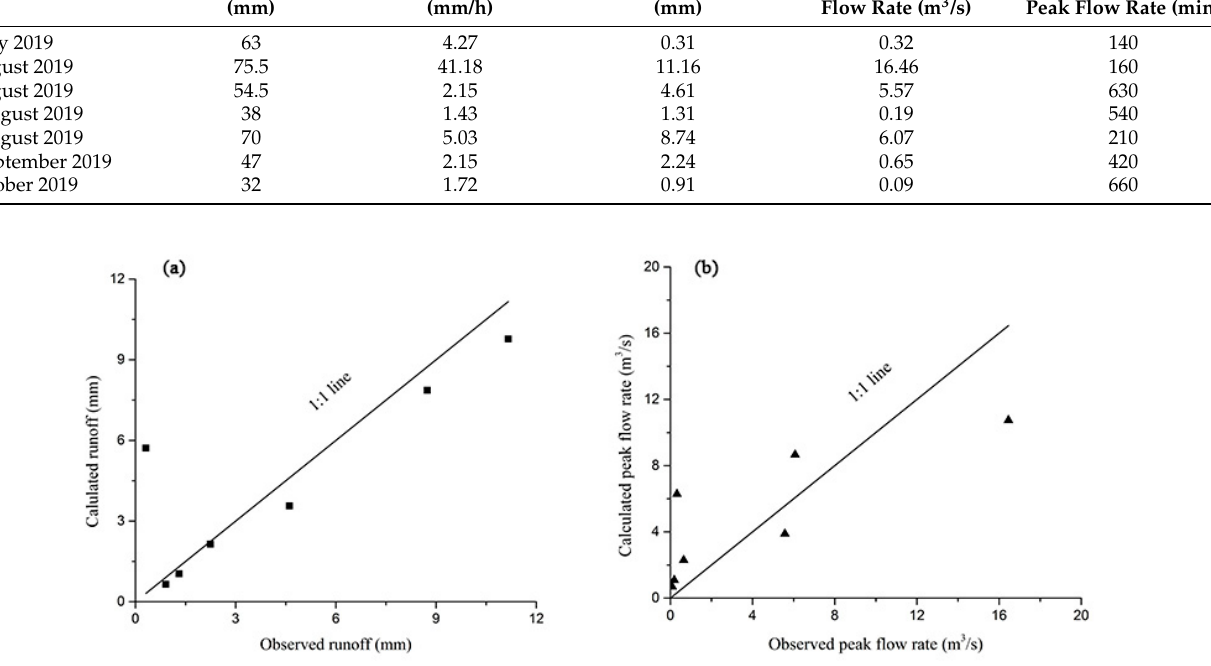
Figure 6. Scatter diagrams between observed and calibrated runoff ( a ) and peak flow rate ( b ).